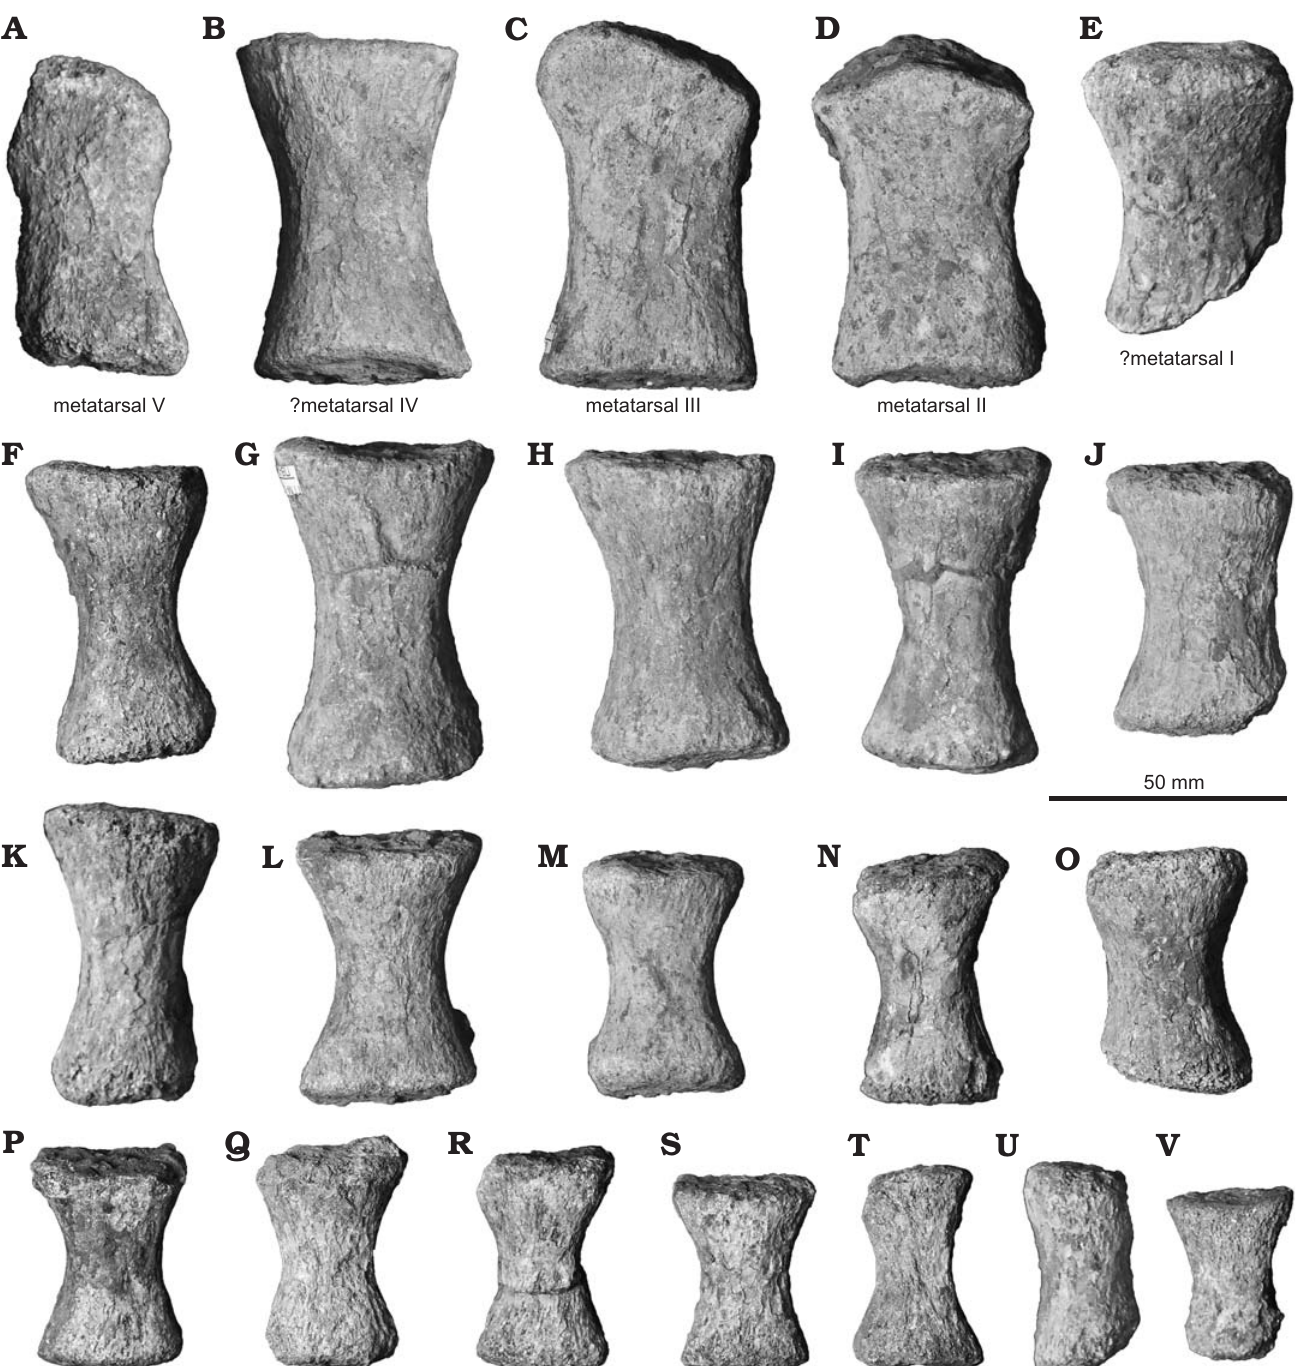
Fig. 9. Metatarsals (A − E) and phalanges (F − V) of the plesiosaur Rhomaleosauridae indet. from the Lower Callovian Hlebnovka Formation of “Konnyi barak” ravine, Russia, in ?dorsal view. A . SGM 1445-120. B . SGM 1445-115. C . SGM 1445-109. D . SGM 1445-114. E . SGM 1445-20. F . SGM 1445- 118. G . SGM 1445-17. H . SGM 1445-116. I . SGM 1445-112. J . SGM 1445-117. K . SGM 1445-19. L . SGM 1445-111. M . SGM 1445-119. N . SGM 1445-18. O . SGM 1445-113. P . SGM 1445-10. Q . SGM 1445-11. R . SGM 1445-12. S . SGM 1445-14. T . SGM 1445-15. U . SGM 1445-13. V . SGM 1445-16. The arrangement of phalanges is not intended to represent their positions in